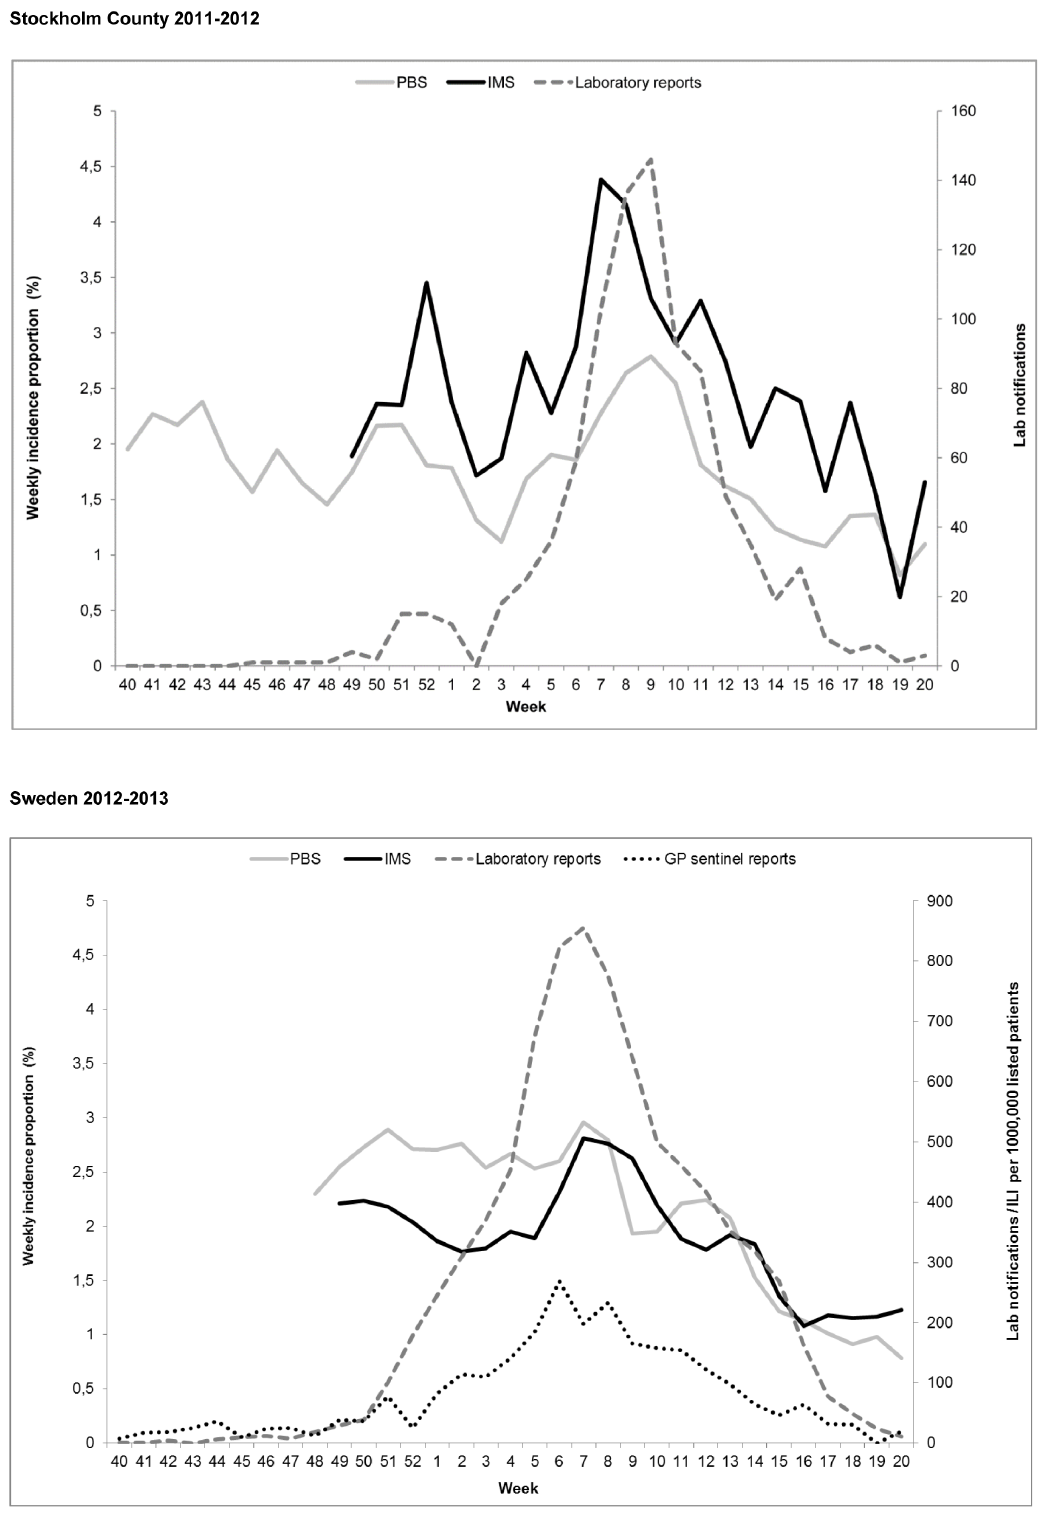
Figure 1. Epidemic curves 2011–2012 and 2012–2013. The upper graph shows the smoothed weekly ILI incidence proportions generated by IMS and PBS (corrected for estimated demographic misrepresentation [4] and underreporting [5]) and number of laboratory confirmed influenza cases, Stockholm 2011–2012. The lower graph shows the smoothed weekly ILI incidence proportions generated by IMS (based on self-recruited and invited participants) and PBS (corrected for estimated demographic misrepresentation [4] and underreporting [5]), number of laboratory confirmed influenza cases, and ILI per 1,000,000 listed patients in GP-sentinel reports, Sweden 2012–2013.